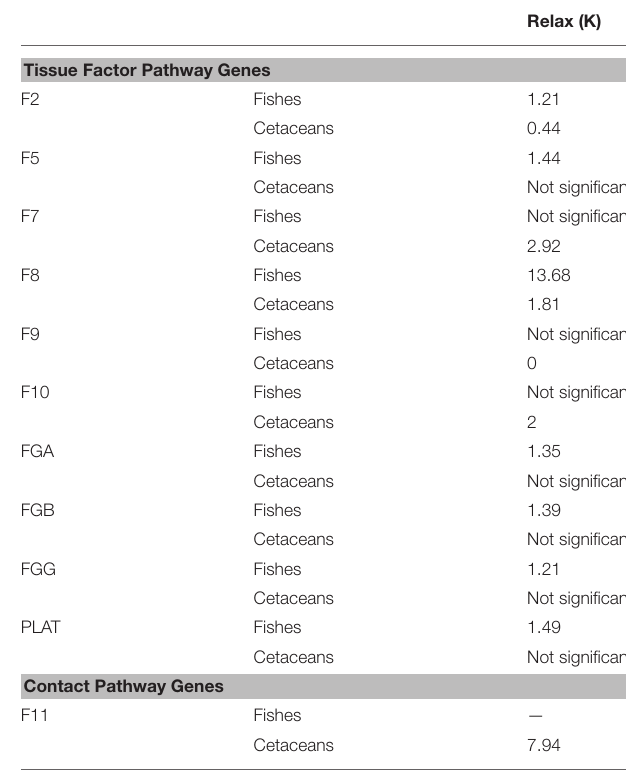
TABLE 2 | Summary of the results from RELAX